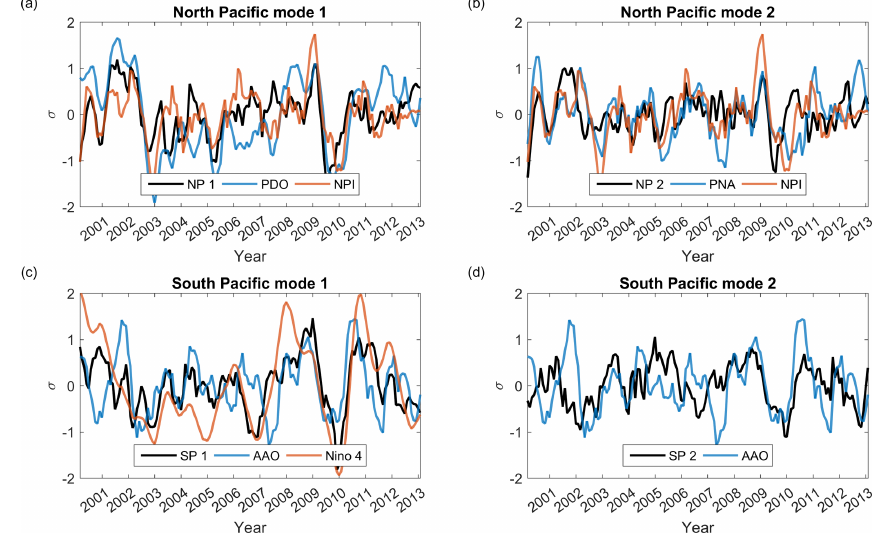
Figure 5. Time series from the top two North and South Pacific MCA modes, shown along with the most correlated CPC indices identified in Fig. 3. The North Pacific index (NPI) is strongly connected to both North Pacific MCA modes (a, b) , with correlations of 0.56 and 0.42 for modes 1 and 2, respectively. In the South Pacific, mode 1 (c) is strongly correlated with the Nino 4 index ( − 0 . 50), whereas mode 2 (d) is correlated with the Southern Annular Mode (0.32). In the plots above, the sign of each index that is negatively correlated with the MCA mode shown has been flipped and a 5-month boxcar filter has been applied to make the plots more readable. No filtering was applied to derive the correlation coefficients given (the correlations between all CPC indices and all MCA modes are given in Fig.